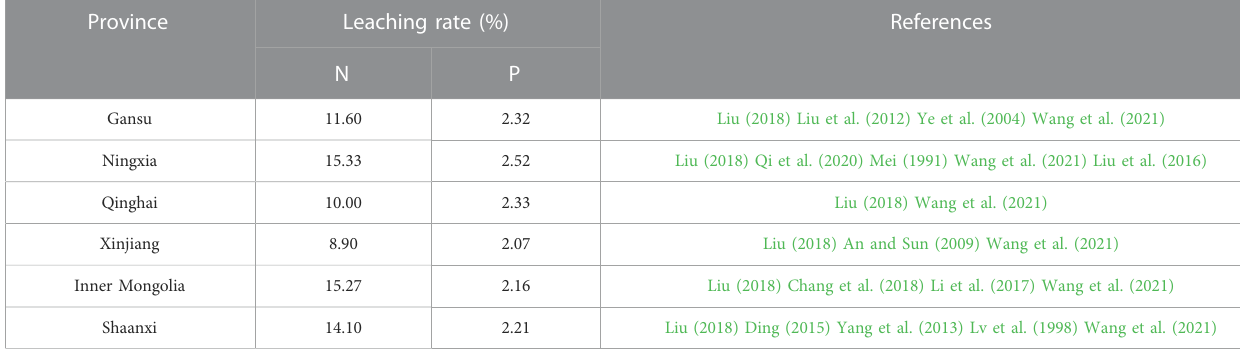
TABLE 3 Leaching rates of N and P in six provinces in western China.